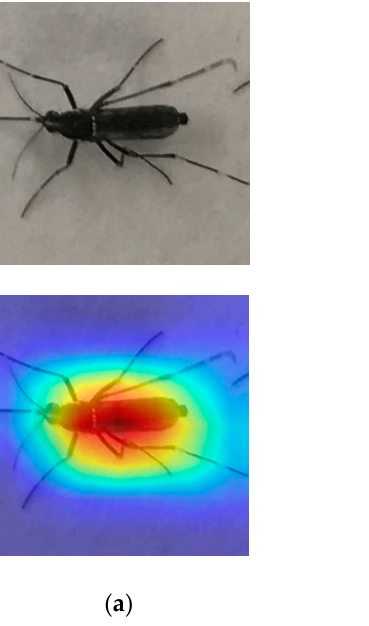
Figure 8. Activation visualization by gradient-weighted class activation mapping (Grad-CAM): ( a ) Aedes albopictus , ( b ) Anopheles stephensi , and ( c ) Culex pipiens pallens .